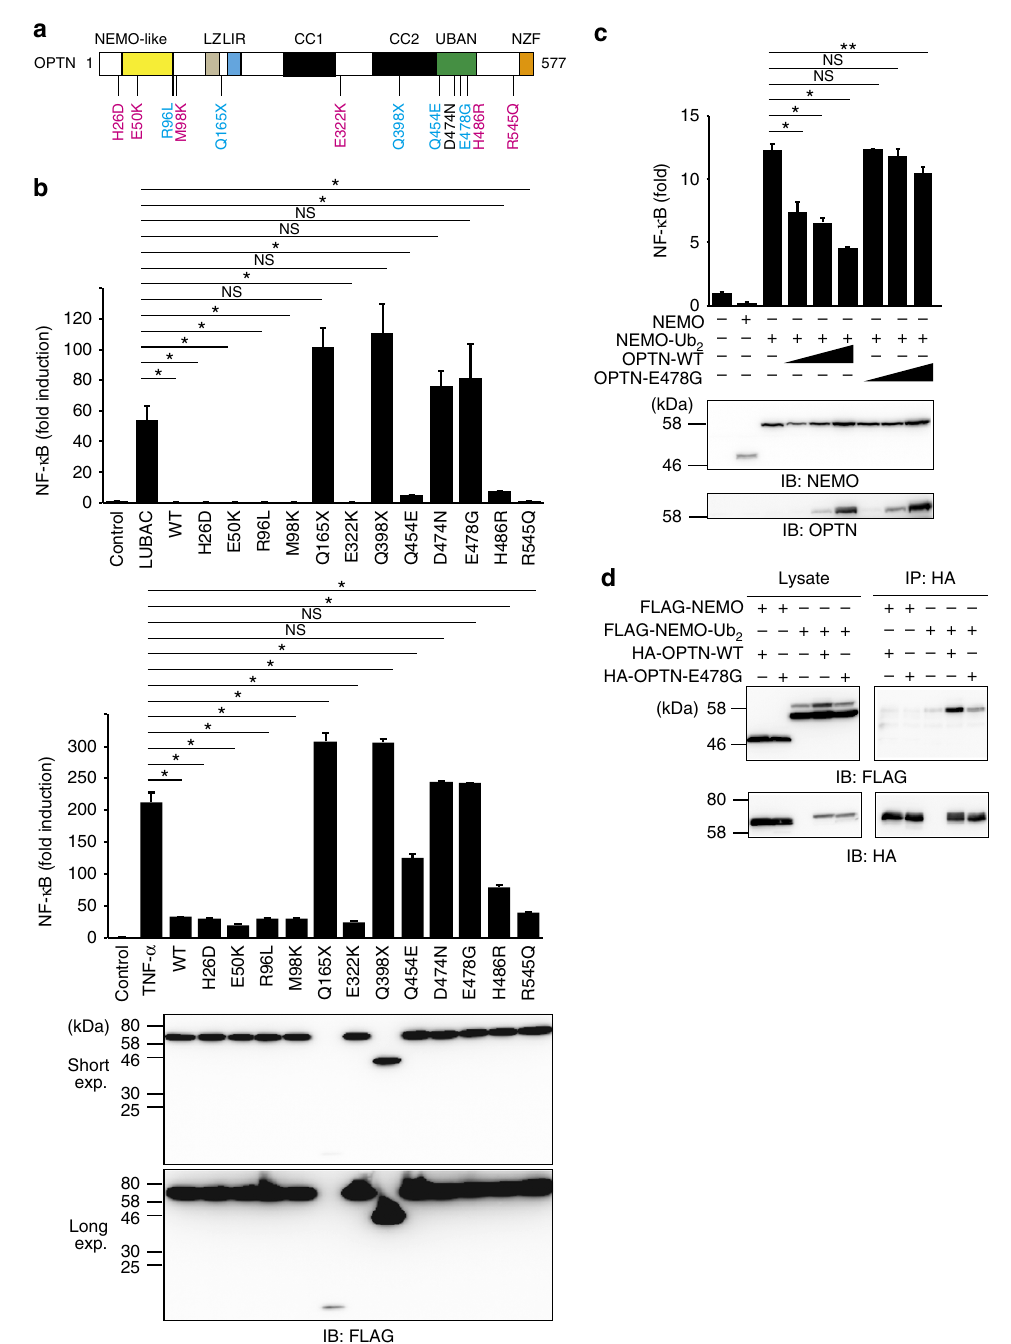
Figure 1 | ALS-associated OPTN mutants fail to suppress NF- j B activity. ( a ) Domain structure of OPTN and disease-associated mutations. CC, coiled-coil; LZ, leucine zipper; LIR, LC3-interacting region; NZF, Npl4-type zinc finger; UBAN, ubiquitin binding in A20-binding I k B (ABIN) and NEMO proteins. Blue, ALS-associated mutations; pink, POAG-associated mutations. ( b ) Effects of WTand mutants of OPTN on LUBAC- and TNF- a -induced NF- k B activation were examined by luciferase assays in HEK293Tcells. Expression of WTand mutants of FLAG-OPTNs is shown by immunoblotting. ( c ) Effects of WTand E478G mutant of OPTN on linear diubiquitin-conjugated NEMO were examined as in b . ( b , c ) Induction folds of NF- k B activity by luciferase assay are shown as mean ± s.e.m. ( n ¼ 3). Statistical significance was assessed using one-way analysis of variance. * P o 0.001 and ** P o 0.01, NS, not significant. ( d ) WT-OPTN, but not the E478G mutant, binds to linear di-ubiquitinated NEMO. Immunoprecipitation and immunoblotting were performed as indicated. linearly di-ubiquitinated NEMO (Fig. 1c) 31 . OPTN-WT, but